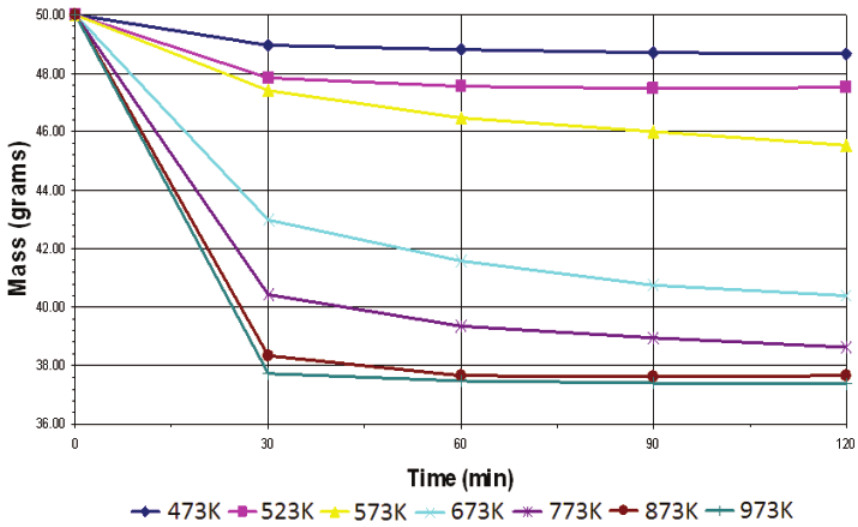
Fig. 3: Dehydration of WM2